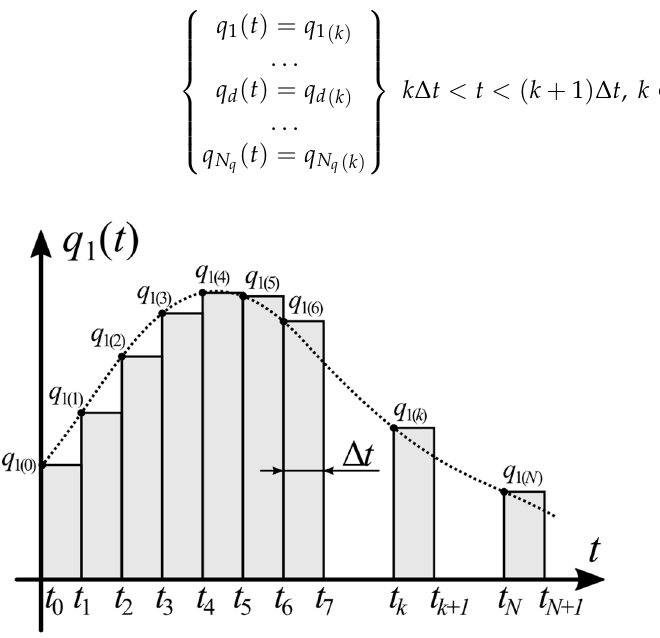
Figure 2. Staircase estimation of heat flux q 1 ( t ) at the boundary Γ 1 .